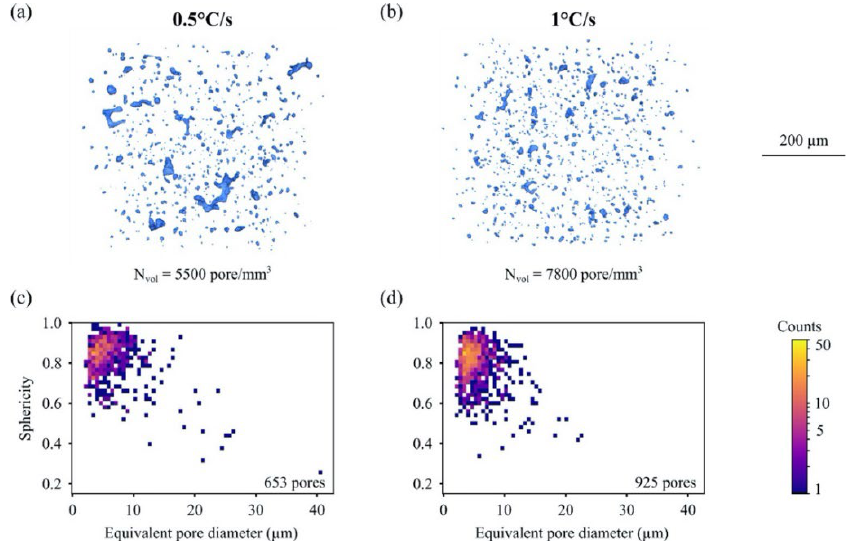
Figure 2. 3D view of the porosity after complete solidification for two cooling rates: ( a ) 0.5 °C/s and ( b ) 1 °C/s. The pore population in terms of size and sphericity for a cooling rate of ( c ) 0.5 °C/s and ( d ) 1 °C/s [36] .